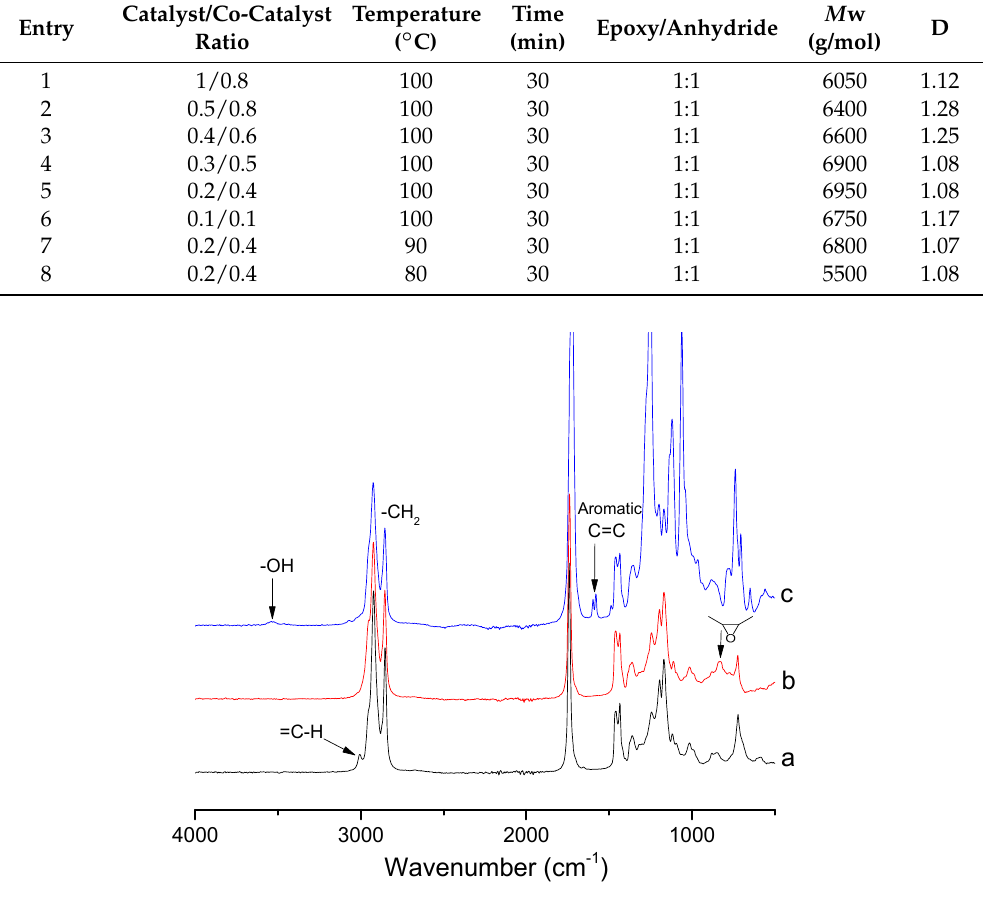
Figure 1. Attenuated total reflection-Fourier transform infrared spectroscopy (ATR-FTIR) spectra of ( a ) fatty esters; ( b ) epoxidized fatty esters and ( c ) polyesters.